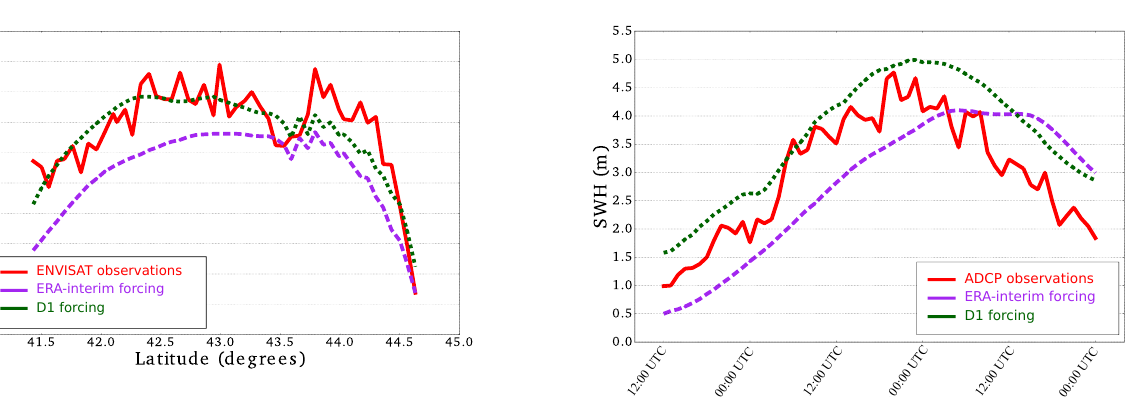
Figure 5. Comparison of the simulated significant wave heights (SWHs) with downscaled wind input and ERA-Interim wind input with the data from the ENVISAT track crossing the western Black Sea at 20:00UTC on 7 February 2012. Purple and green stand for ERA-Interim and D1 forcing, respectively. Red line stands for EN- VISAT observations.